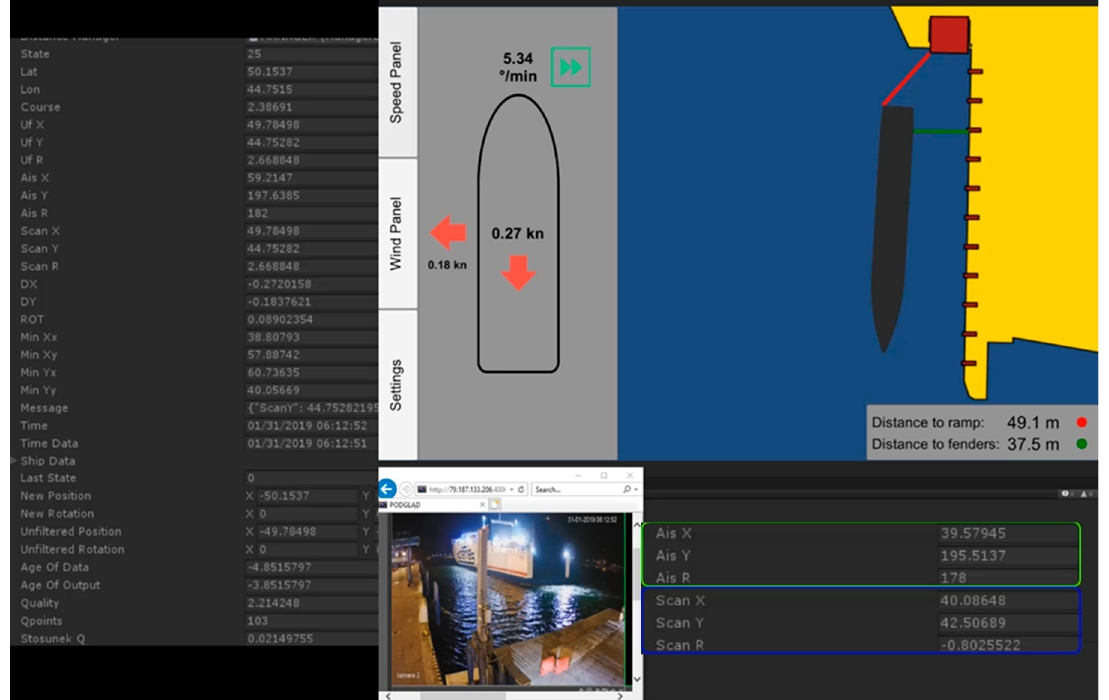
Figure 11. Test application prepared for the purpose of verification of pilot navigation docking system (PNDS) system and comparison of position reported AIS and calculated by PNDS system (green and blue frames).